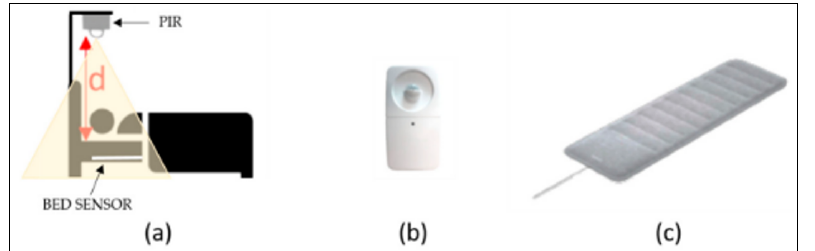
Figure 20. Examples of multiple signals. ( a ) A two-channel monitoring system. ( b ) PIR sensor; ( c ) Nokia sleep bed sensor [255]. Reproduced under the terms of the CC-BY Creative Commons Attribution License, Copyright 2019 by the authors, published by MDPI.